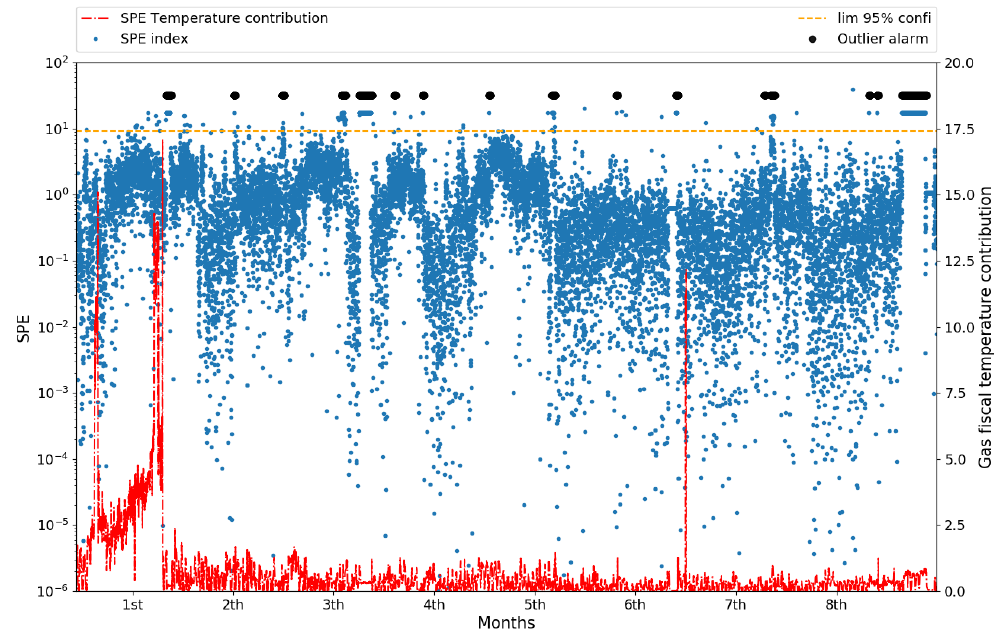
Figure 5. SPE statistic for sensor fault in Fiscal Metering Station II during eight months. In red, the dynamic behavior of the gas fiscal temperature contribution to SPE. Dots represent fault alarm activation. The orange dashed line is the detection